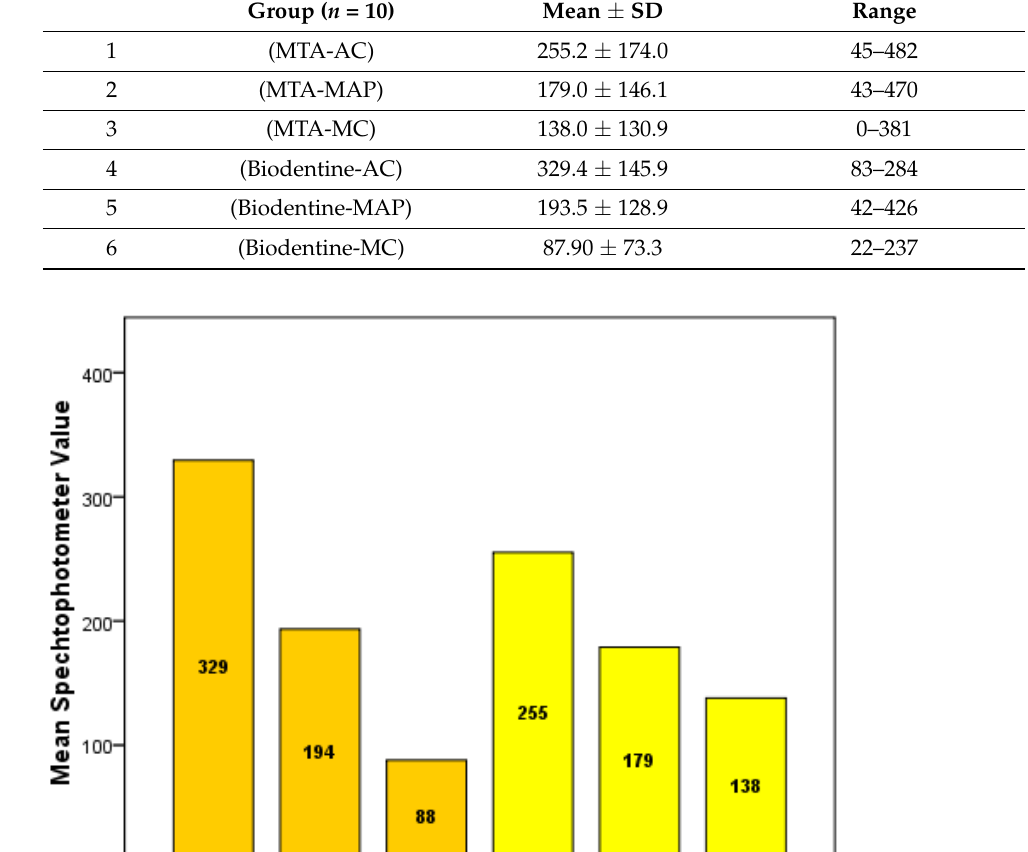
Table 3. Mean and range of apical microleakage scores.